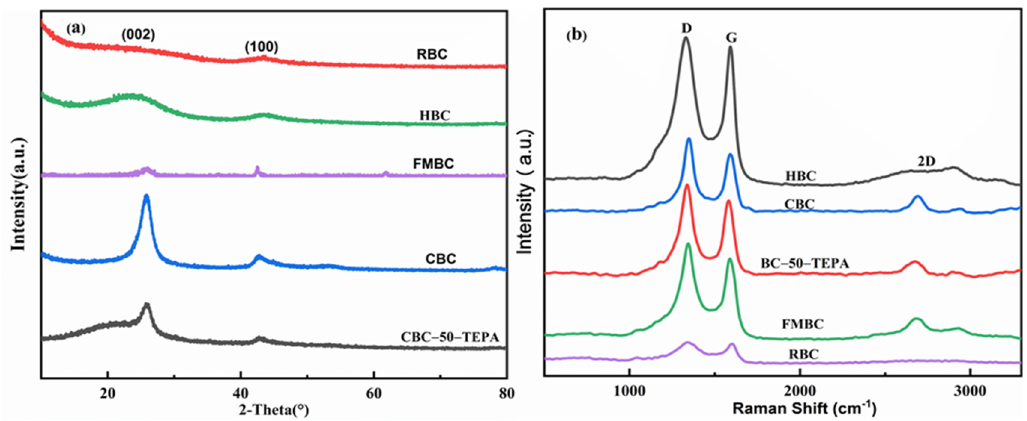
Figure 4. XRD spectra ( a ), Raman spectra of biochar from different activation methods, and CBC-50- TEPA ( b ).